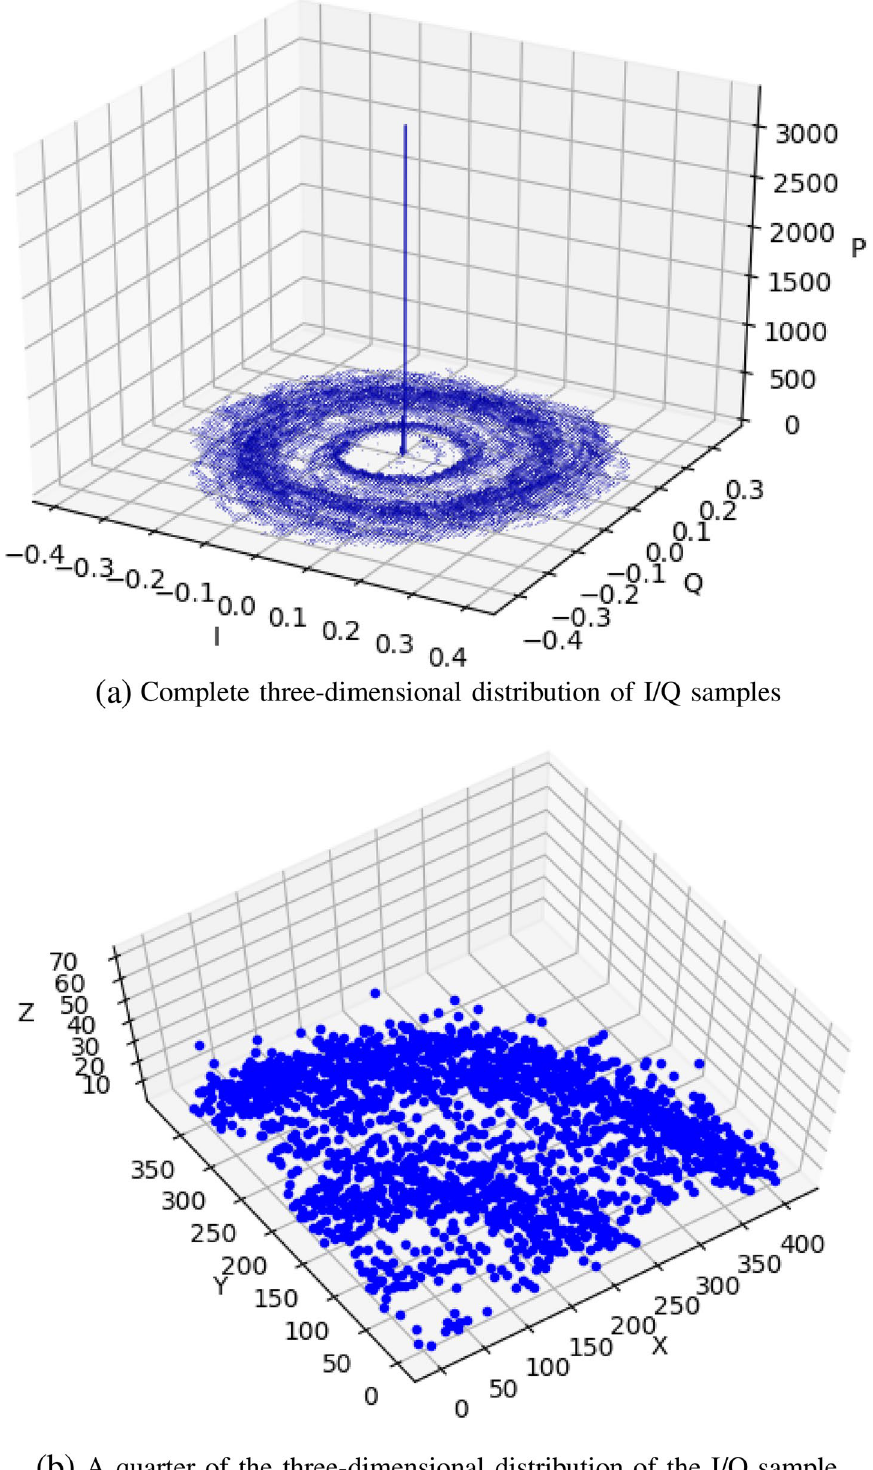
Figure 4. I/Q distribution of FSK signal (40 dB). I/Q components are mainly distributed in I , Q ∈ [− 0.4, + 0.4 ]